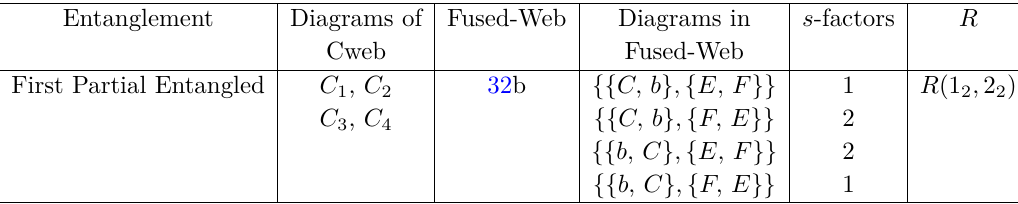
Table 22. Fused-Webs and their mixing matrices for Cweb W (4)